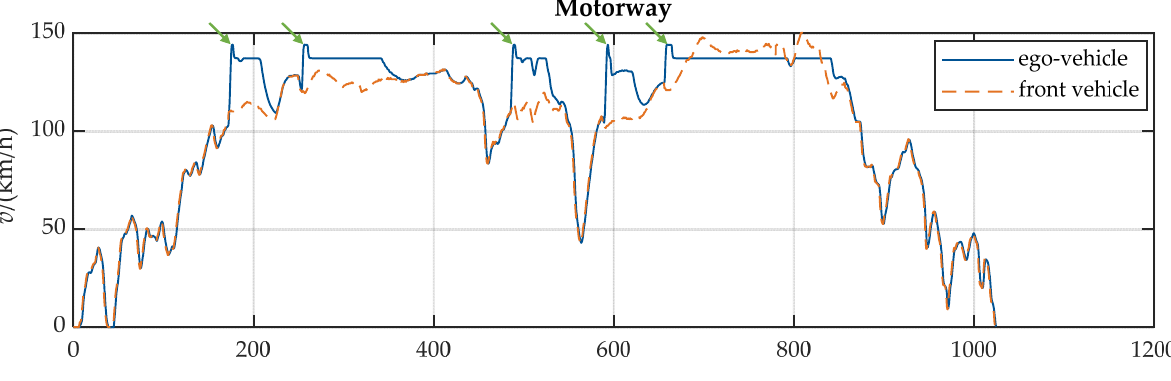
Figure 18. Motorway cycle for the swift driving style.